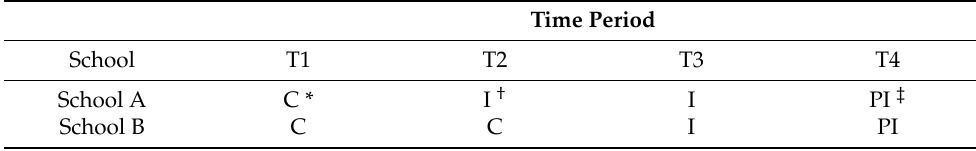
Table 1. Time periods by